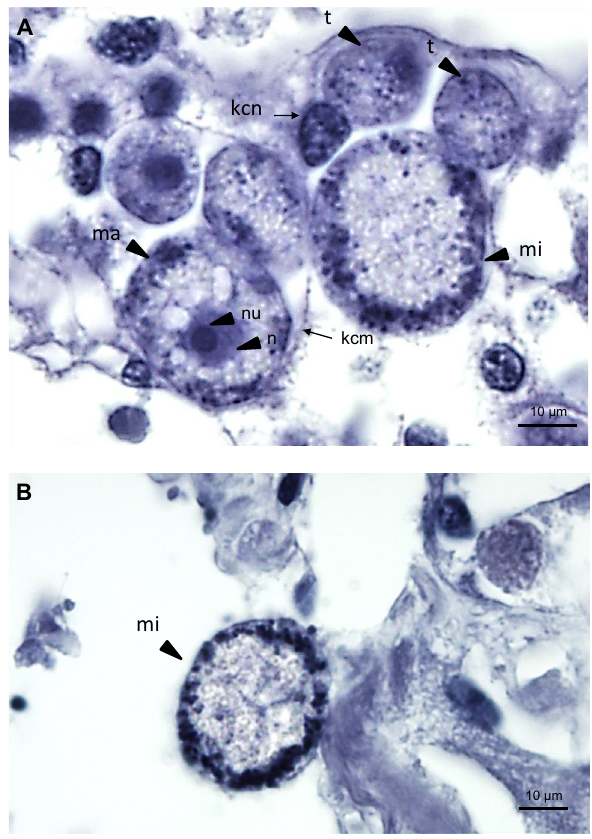
Figure 6. Micrographs of the most common BSM forms ( A ) found in histological section of bay scallop kidney (H&E stain). ( B ) Microgamont. Letters indicate kidney cell nucleus (kcn), kidney cell membrane (kcm), macrogamont (ma), macrogamont nucleus (n), macrogamont nucleolus (nu), microgamont (mi), trophozoites